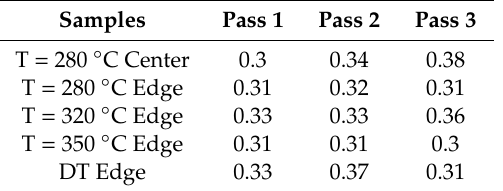
Figure 11. The (0001) <11 − 20> Schmid factor distribution maps of different samples: ( a ) Center pass 1 at 2800°C; ( b ) Center pass 2 at 280°C; ( c ) Center pass 3 at 280°C; ( d ) Edge pass 1 at 280°C; ( e ) Edge pass 2 at 280°C; ( f ) Edge pass 3 at 280°C; ( g ) Edge pass 1 at 320°C; ( h ) Edge pass 2 at 280°C; ( i ) Edge pass 3 at 320°C; ( j ) Edge pass 1 at 350°C; ( k ) Edge pass 2 at 350°C; ( l ) Edge pass 3 at 350°C; ( m ) Edge pass 1 at DT; ( n ) Edge pass 2 at DT; ( o ) Edge pass 3 at DT. Table 2. Average values of (0001) <11 − 20> Schmid factor of different samples.